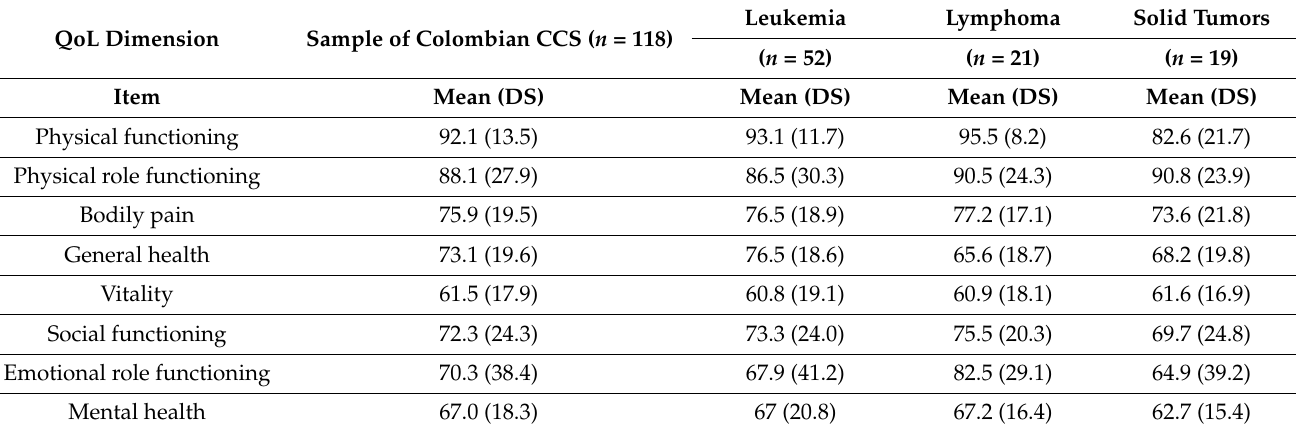
Table 4. Description of quality of life based on SF-36 questionnaire according to cancer type.